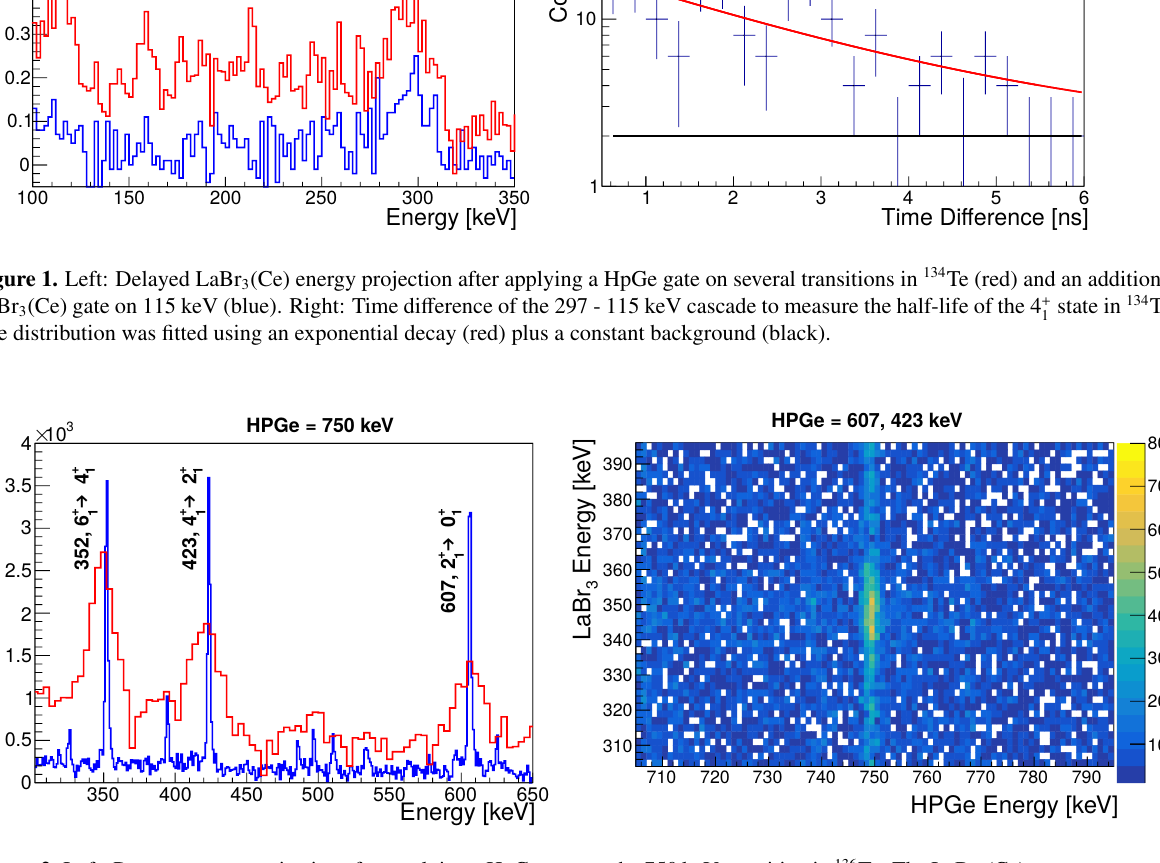
Figure 2. Left: Prompt energy projection after applying a HpGe gate on the 750 keV transition in 136 Te. The LaBr 3 (Ce) energy spectrum is shown in red and the HpGe spectrum in blue. The strongest transitions from 136 Te are labeled with their respective energies. Right: LaBr 3 (Ce) - HpGe energy matrix after gating on the two lowest transitions in 136 Te. The zoomed area corresponds to the 750 - 352 keV